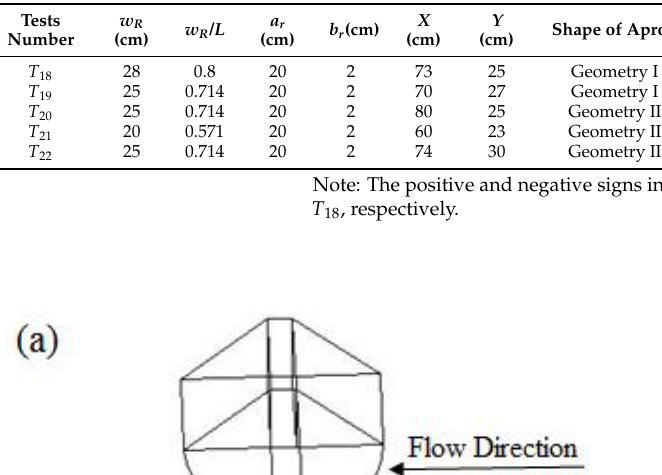
Table 4. Results of different geometry and scale ratios of apron at spill-through abutment.